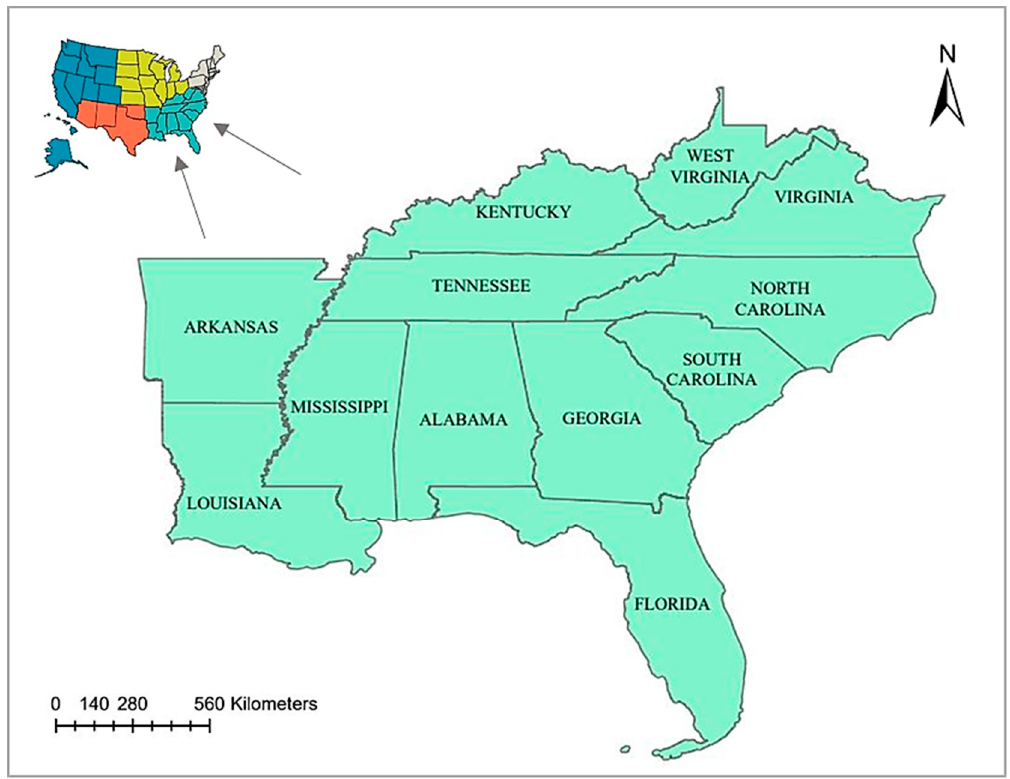
Figure 1. Showing the southeastern region of the United States of